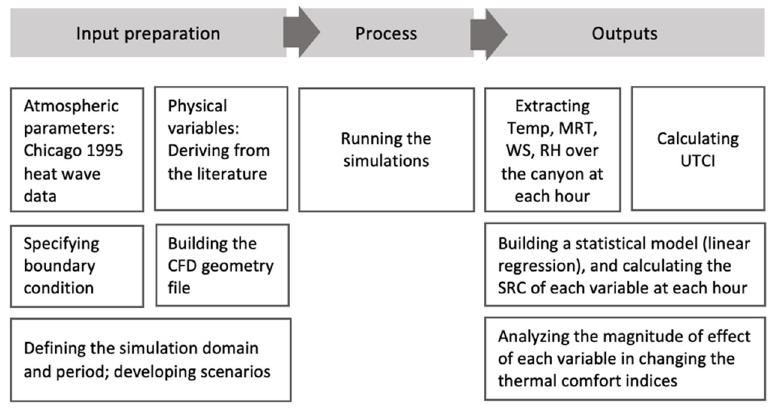
Figure 1. Overview of research